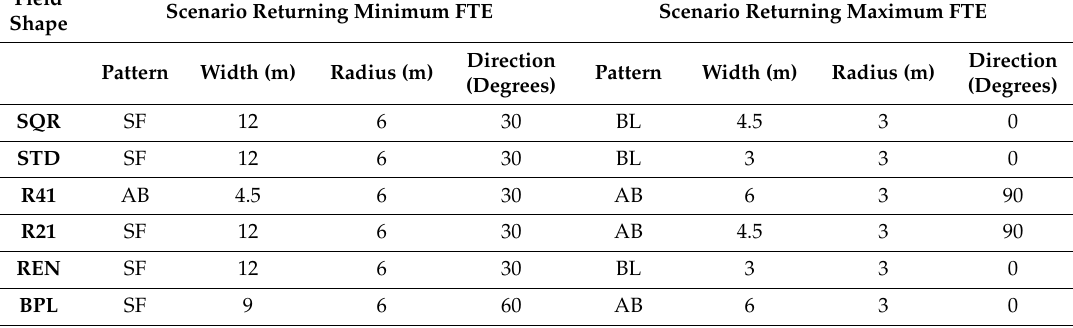
Table 2. The scenarios for min, max computed FTE in each test field.